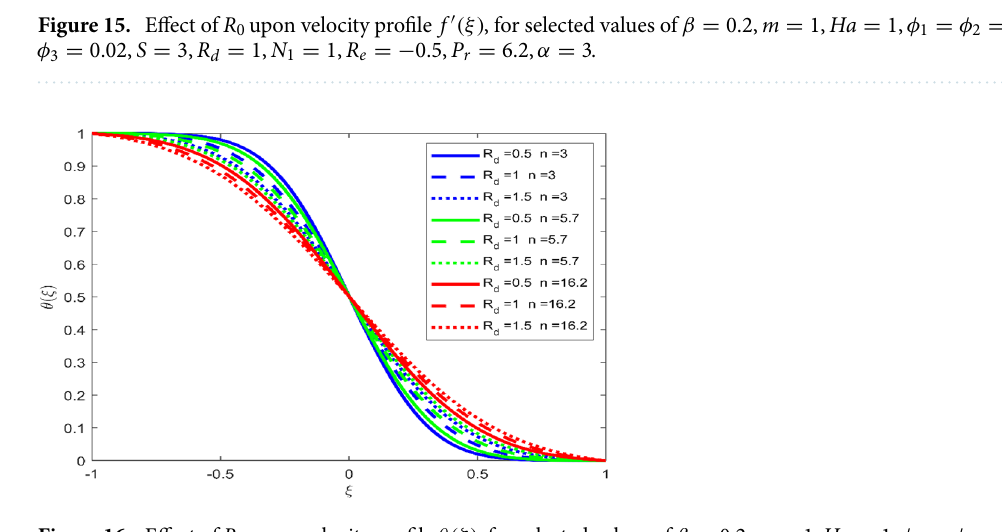
Figure 16. Effect of R d upon velocity profile θ(ξ) , for selected values of β = 0.2, m = 1, Ha = 1, φ 1 = φ 2 = φ 3 = 0.02 , R 0